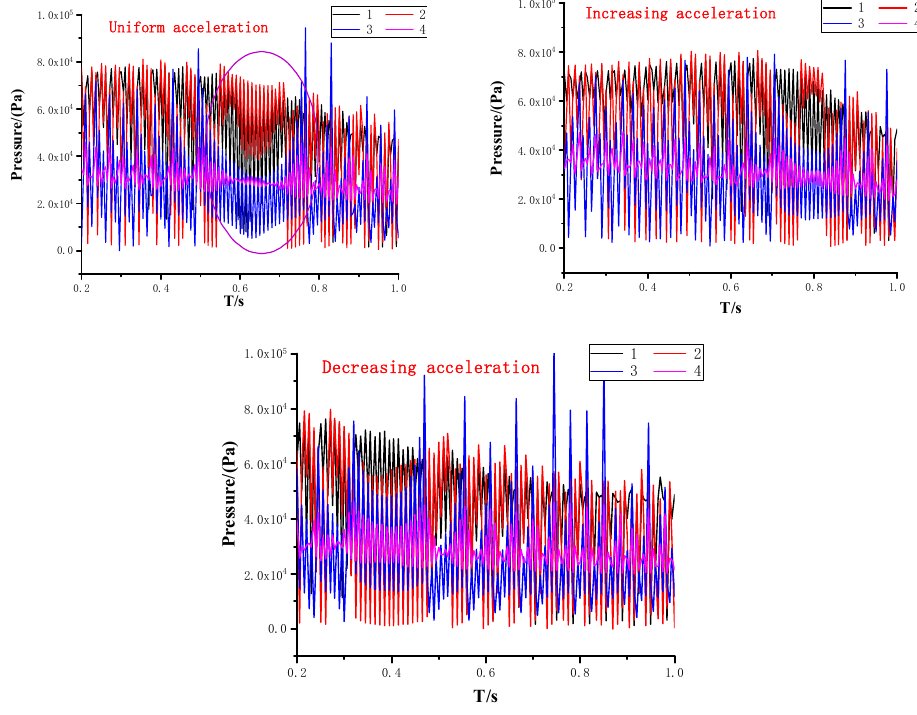
Figure 12. Cavitation pressure distribution at impeller area.